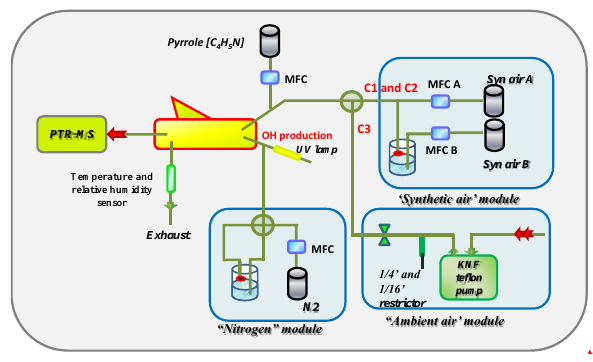
Figure 1. OH reactivity system during MEGAPOLI winter 2010 2 Fig. 1. OH reactivity system during MEGAPOLI winter